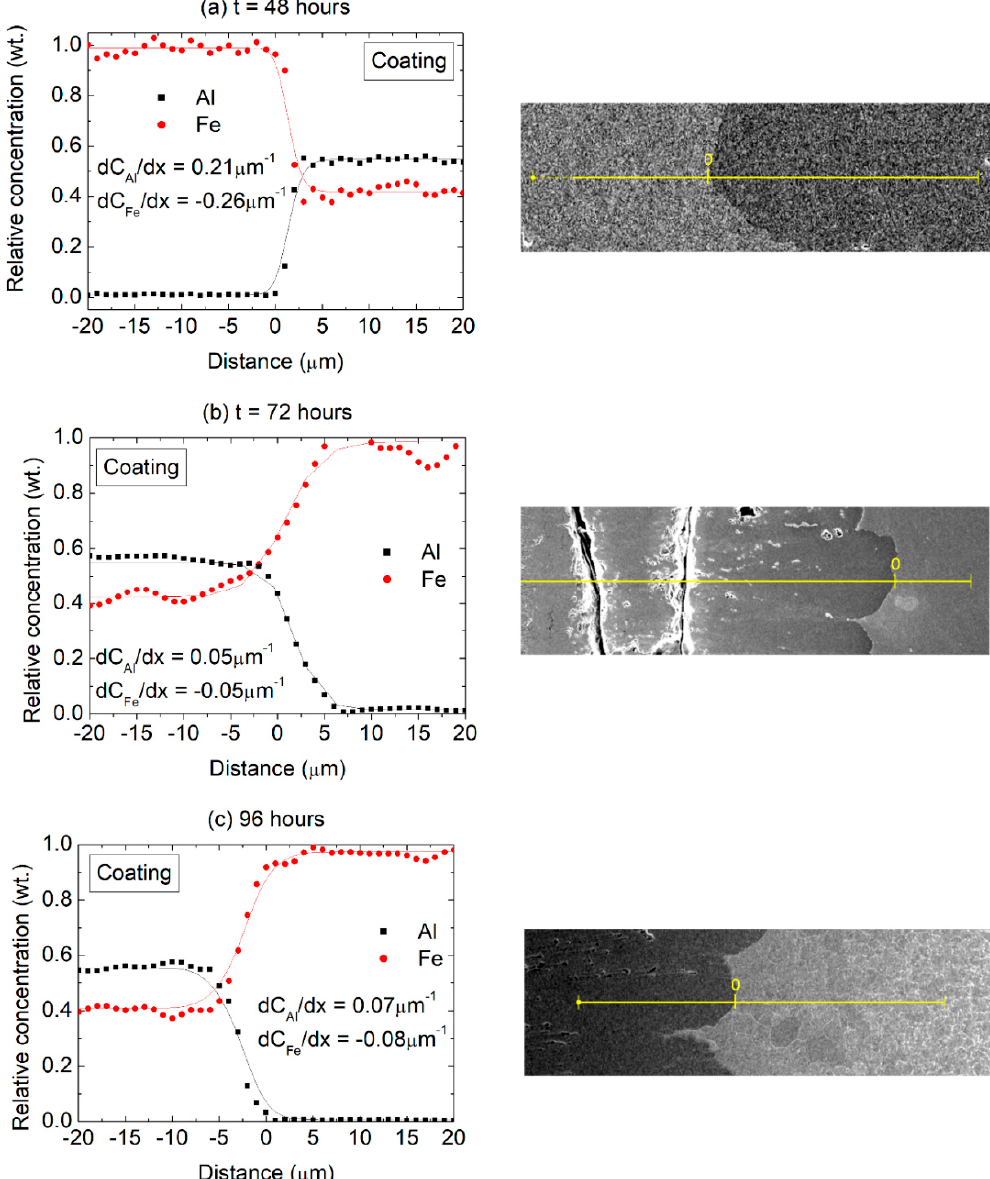
Figure 7. Composition profiles (Al and Fe) across the coating/substrate interface after ( a ) 48 h, ( b ) 72 h and ( c ) 96 h at 550 °C with the corresponding positions of the EDS scans (BSE imaging mode).